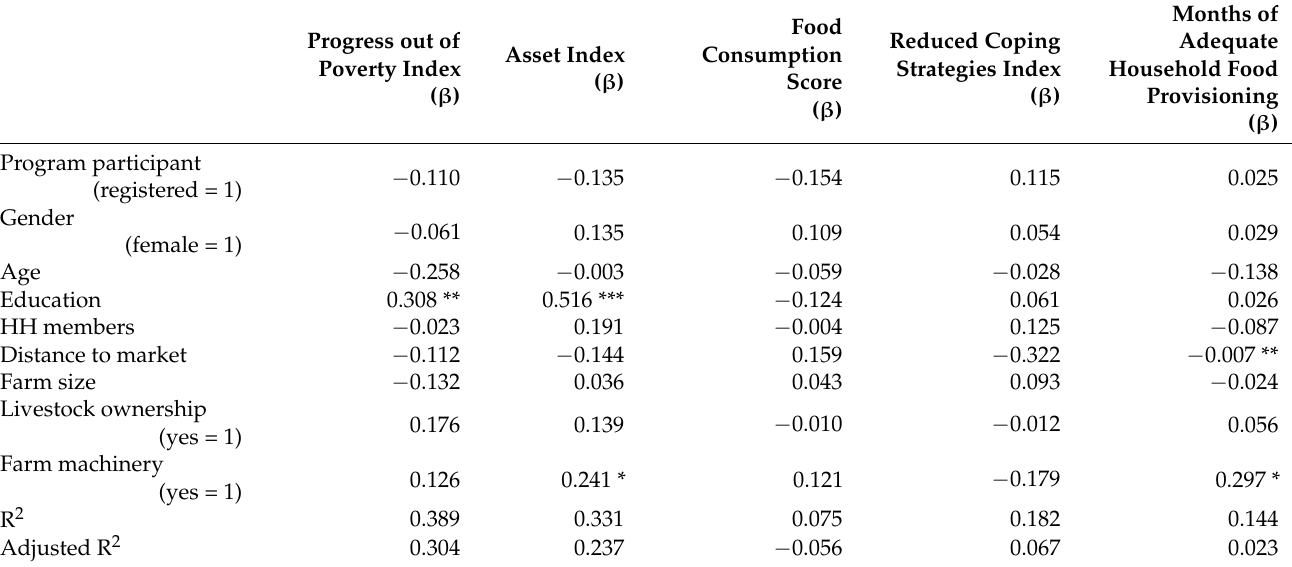
Table A4. Results of estimation of MI program participation as a determinant of poverty in